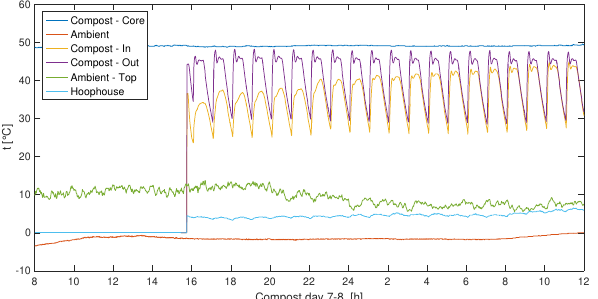
Figure 16. Detail of temperature profiles over days 9–10.